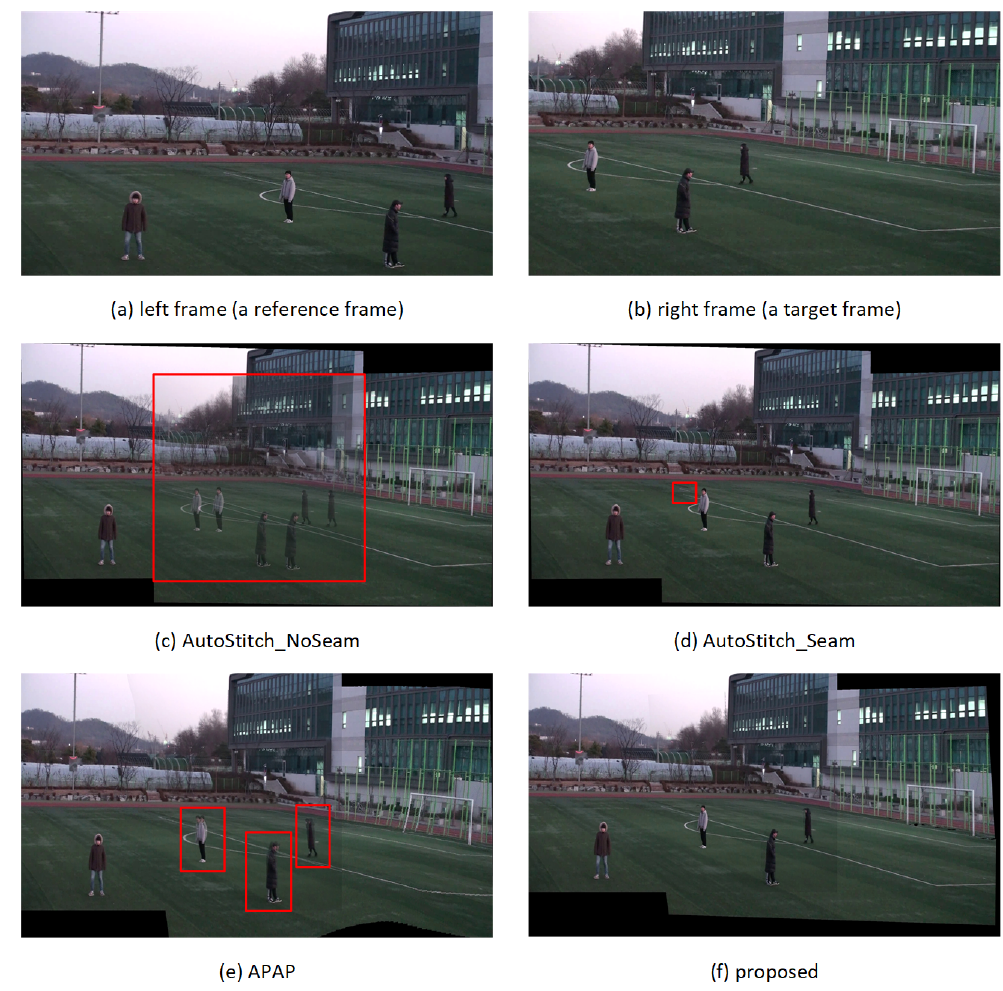
Figure 11. Quality comparison for stitched video frames: seq4